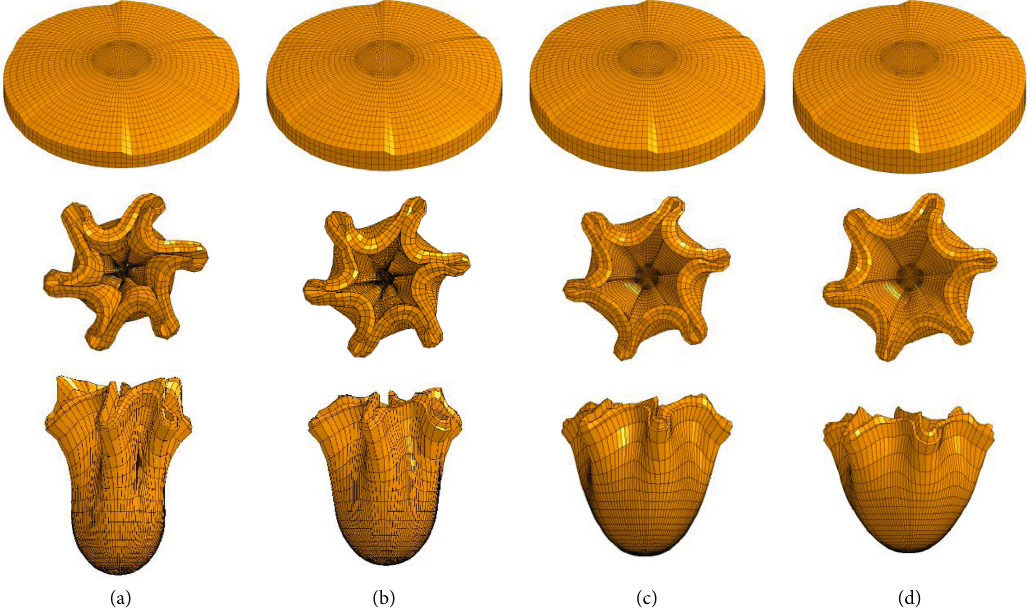
Figure 18: EFP formation for different liner wall thicknesses. (a) d � 2.5mm ( t � 240 μ s, v v